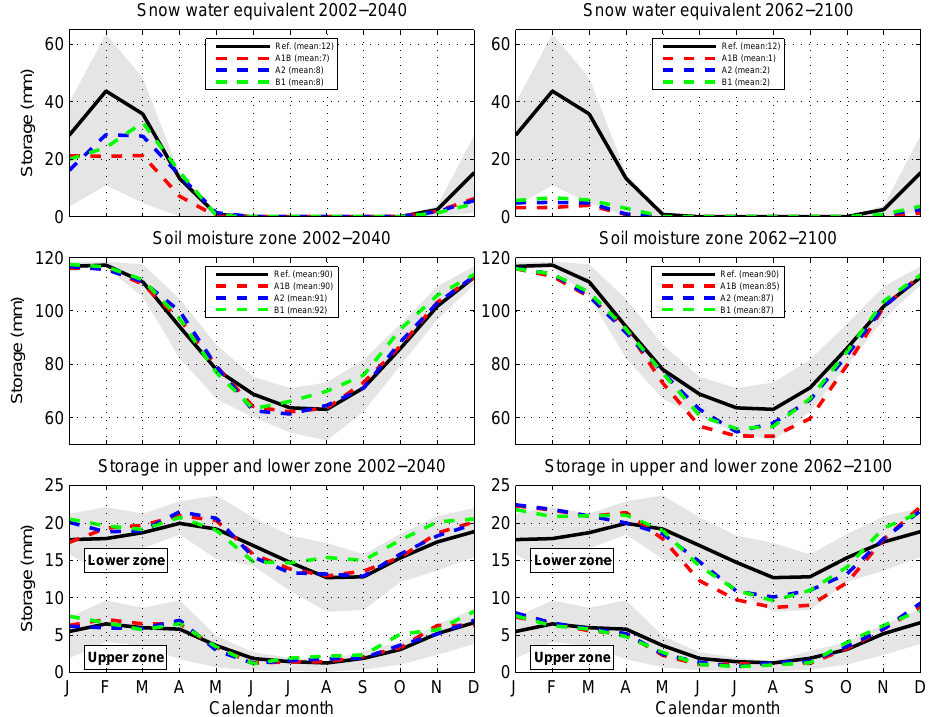
Fig. 7. Mean monthly storages of the snow water equivalent, soil moisture, upper zone and lower zone storage for the reference period and the climate scenarios, shown for the period 2002–2040 (left) and the period 2062–2100 (right). The range between the 25th and 75th percentile of the reference period is plotted as a light gray shaded band. Table 4. Statistics of drought events for the reference period and the climate scenarios for the period 2002–2040 and 2062–2100. A drought event is calculated with respect to a specific threshold discharge. The statistical parameters are indicated with D1, D2 and D3, where D1 is the average number of events per year, D2 is the average of the yearly maximum durations of a drought in days, and D3 is the average of yearly maximum intensities, where the intensity is defined as the deficit volume divided by duration, in m 3 s − 1